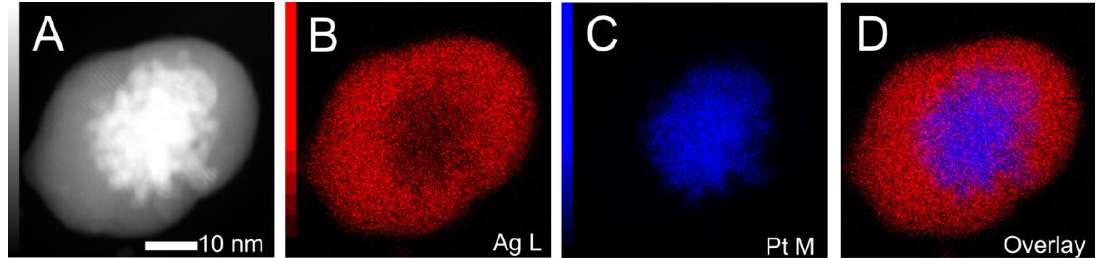
Figure 3. STEM-HAADF image ( A ) and the corresponding EDS elemental maps for silver L line ( B ); platinum M line ( C ); and an overlay of the two maps ( D ) for a single Pt @Ag NP. 25.7 8.1